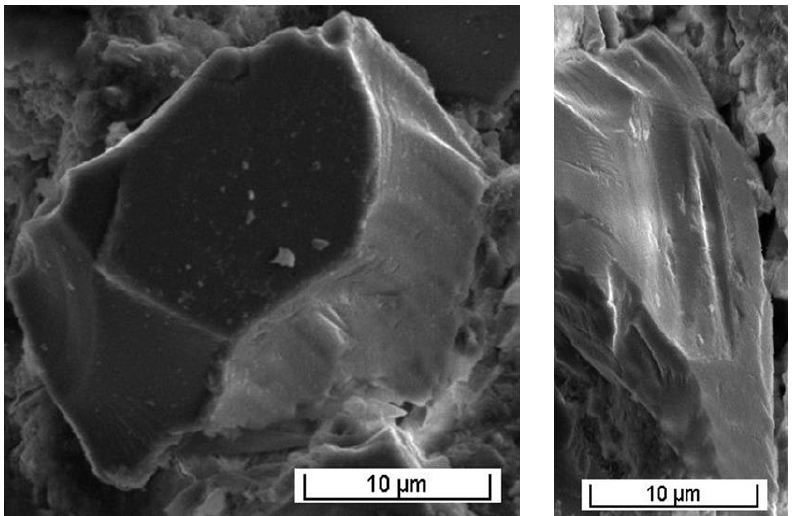
Figure 4. View of a glass powder particle (scanning electron microscopy (SEM) cliche in secondary electrons). Frontal view ( left ) and side view ( right ) [32].